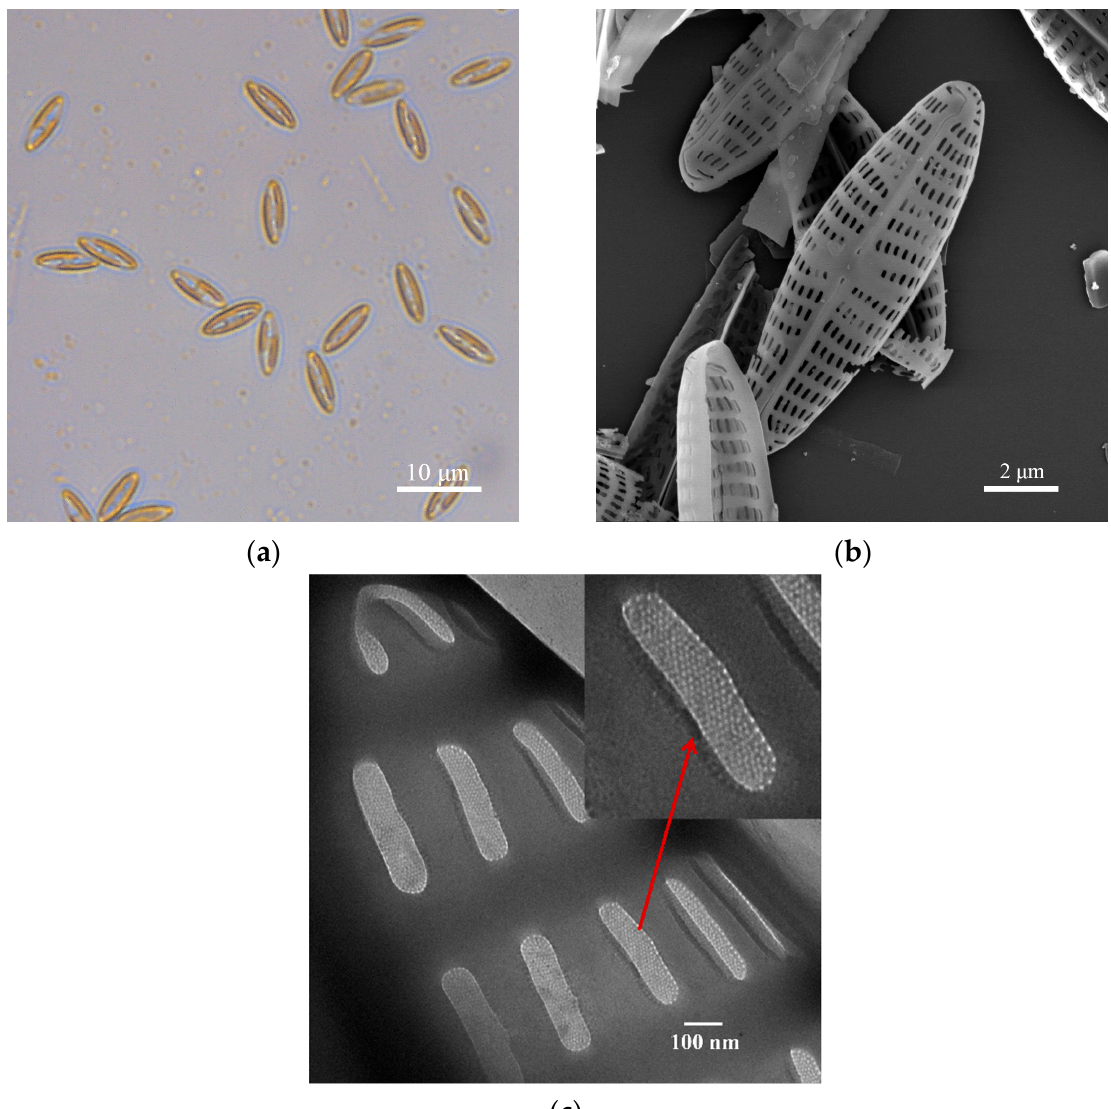
Figure 1. Images of Navicula australoshetlandica sp. living cells and frustules: ( a ) the morphology of diatom cells cultivated in f/2 medium-enriched seawater sodium observed using light microscopy; ( b ) an SEM image of Navicula australoshetlandica sp. frustule; ( c ) details of the frustule structure showing the different arrangement of the porous surface pictured using transmission electron microscopy. Scale bars showing ( a ) 10 µ m, ( b ) 2 µ m, and ( c ) 100 nm, as indicated.